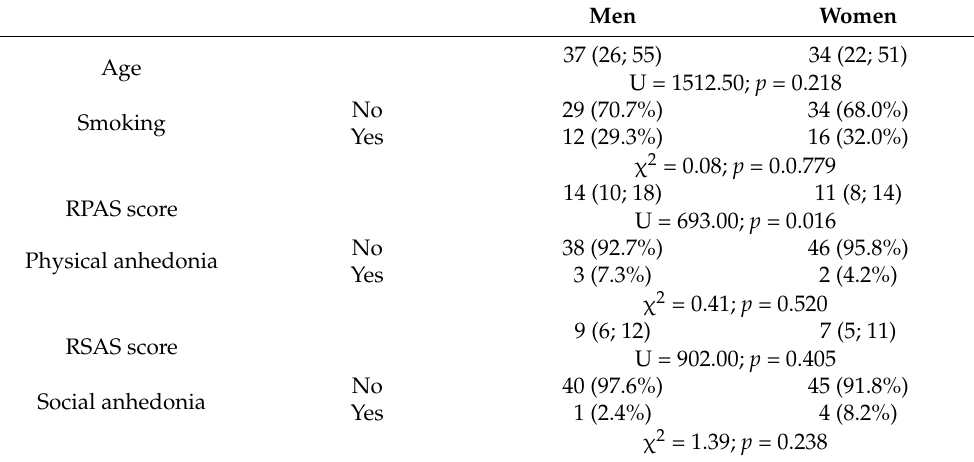
Table 2. Demographic and clinical data of healthy individuals. Data are presented as a number (percentage) or median (Q1; Q3).